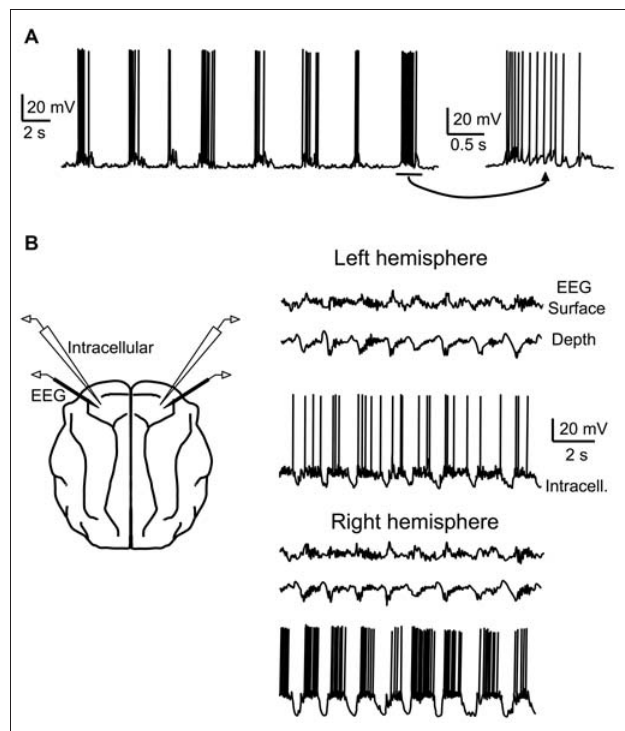
FIGURE 1 | Early recordings of the cortical slow oscillation in anesthetized cats. (A) Intracellular recording from a putative pyramidal cell in cat suprasylvian area five engaged in the slow oscillation under urethane anesthesia. (B) Dual intracellular recordings of putative pyramidal cells during slow oscillation in left (top) and right (bottom) hemispheres of motor cortex in ketamine-xylazine-anesthetized cat. Surface and depth EEG are also recorded in each hemisphere. Cells in both hemispheres are coherent with the population oscillation. (A) adapted by permission from the Society for Neuroscience: Journal of Neuroscience (Steriade et al., 1993a), © 1993. (B) adapted by permission from the Society for Neuroscience: Journal of Neuroscience (Contreras and Steriade, 1995), ©